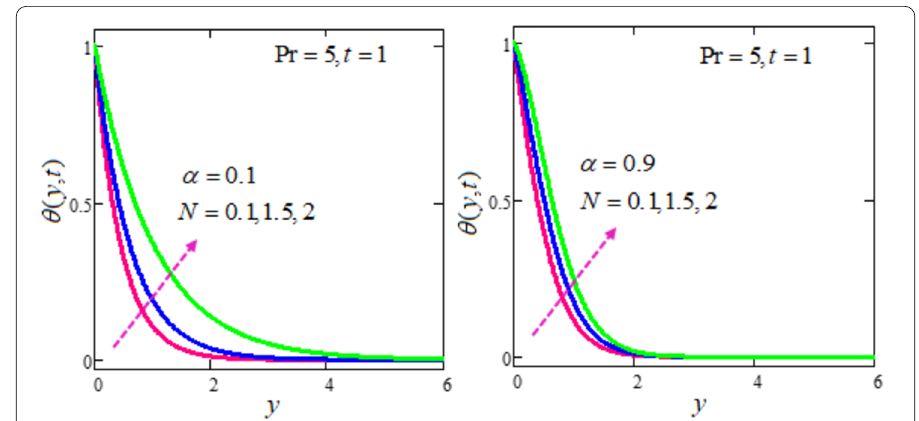
Figure 3 Temperature profile variation with radiation parameter N and fractional parameter α